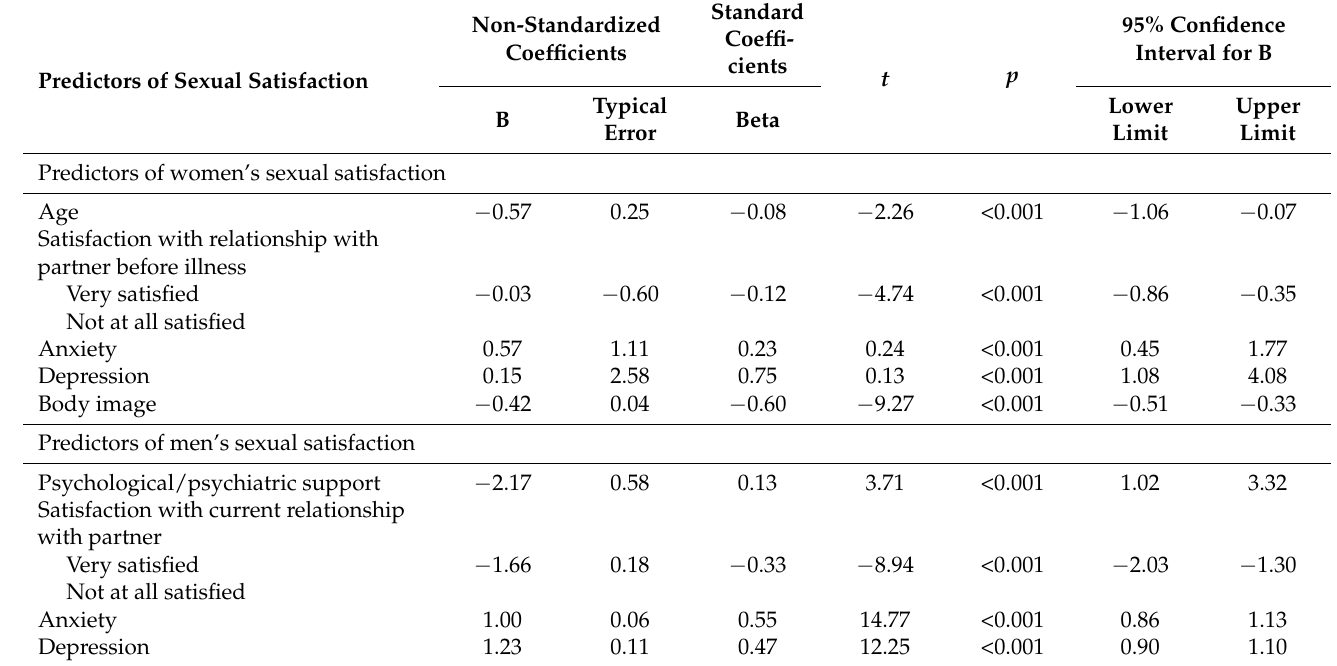
Table 3. Predictors of sexual